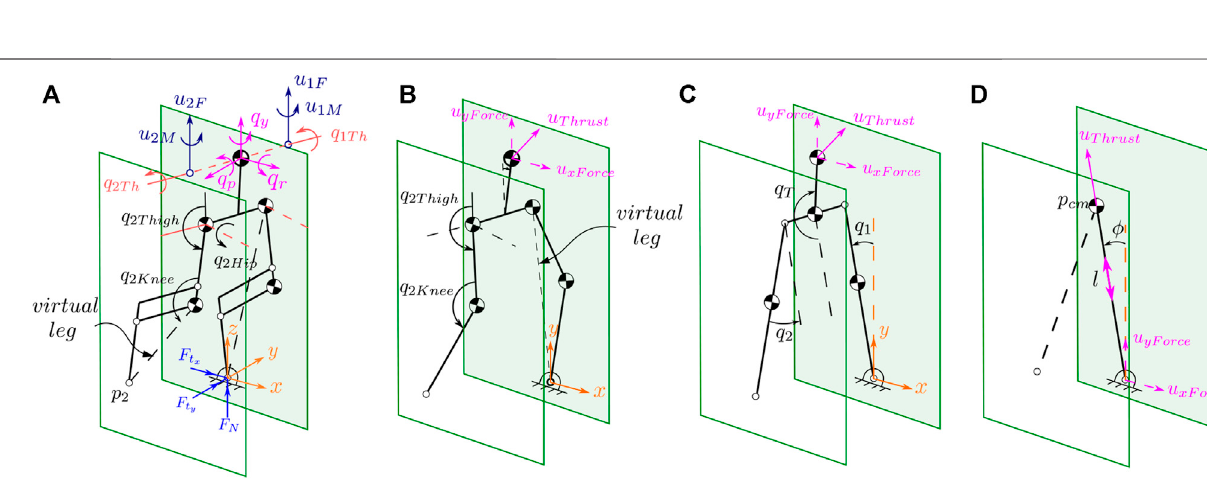
Frontiers in Robotics and AI |